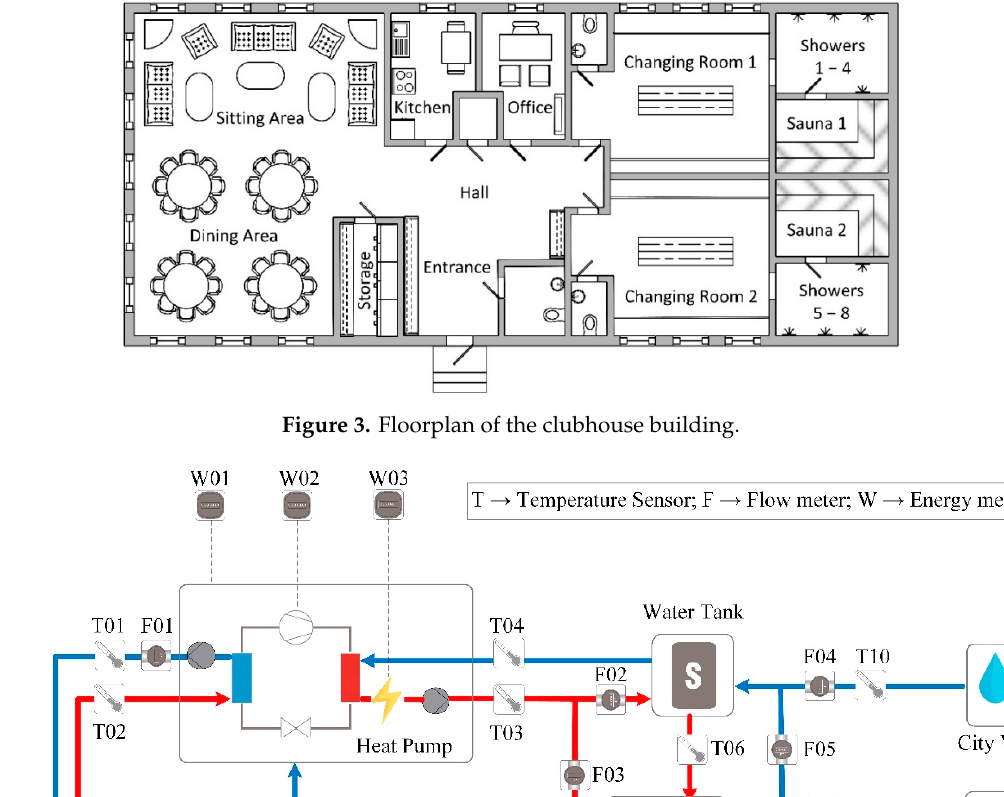
Figure 3. Floorplan of the clubhouse building.